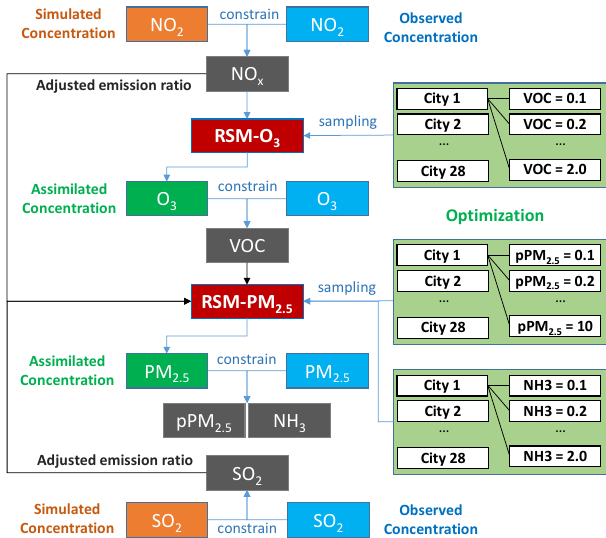
Figure 2. The emission-concentration-based response modeling framework. (In assimilating observational data, NO x and SO 2 emissions were adjusted first, followed by optimization for VOC, and then pPM 2.5 and NH 3 emissions).